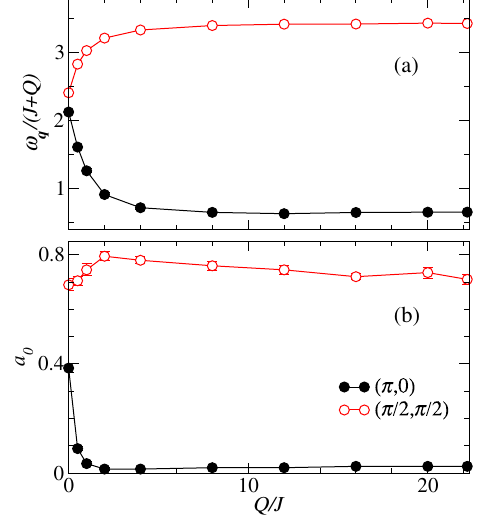
FIG. 13. Results for the J - Q model at q ¼ ð π ; 0 Þ and ð π = 2 ; π = 2 Þ , calculated on the L ¼ 32 lattice. The lowest ex- citation energy ω q (a) and the relative weight of the single- magnon contribution (b) are shown as functions of the coupling ratio Q=J from the Heisenberg limit ( Q=J ¼ 0 ) to the deconfined =J ≈ 22 quantum-critical point ( Q c